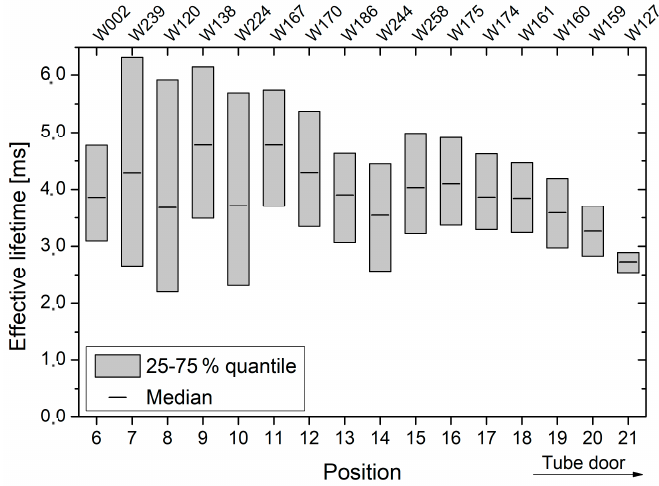
Figure 6. For oxidation run γ , effective lifetimes are shown as a function of the quartz boat position and wafer number, respectively. The quartz boat positions 6–21 contained only 150 mm wafers from batch B, whereby quartz boat position 21 is located in direction of the tube door.